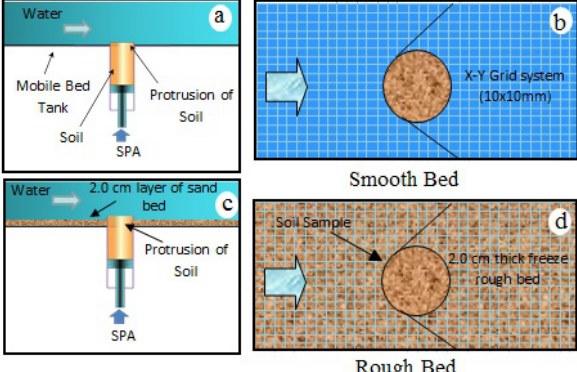
Figure 3: Conceptual diagram of experimental set-up at UEL